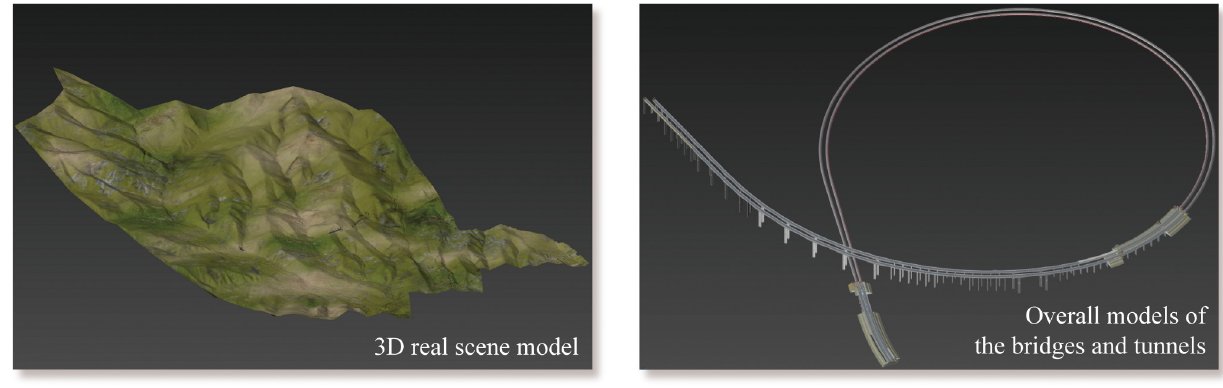
Fig 6. Real scene terrain and BIM